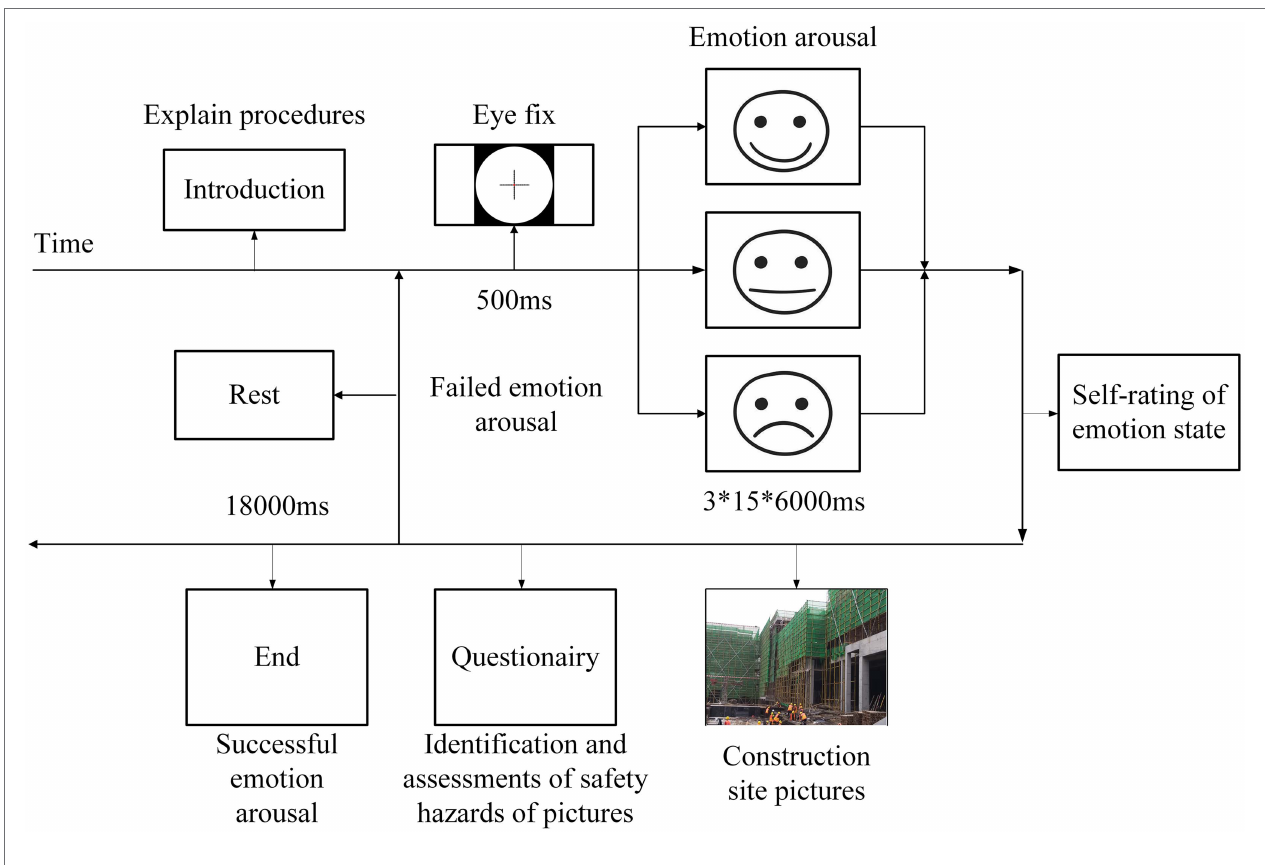
FIGURE 1 | Procedures of the